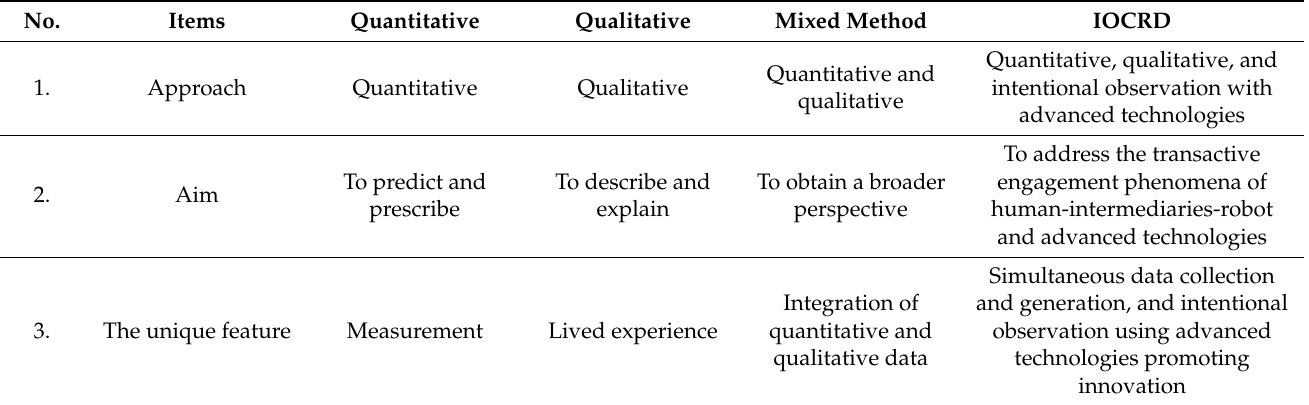
Table 1. Differences between the IOCRD and other research